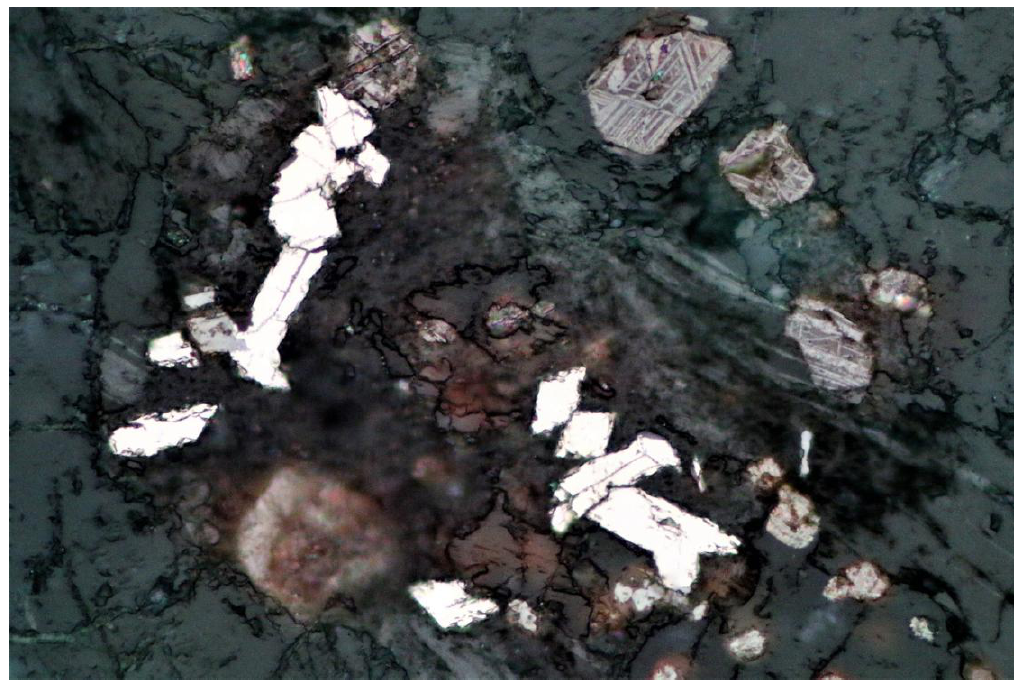
Figure 3. Single and twinned euhedral grains and radially grown crystal aggregates of ferroselite (bright cream) grown inside a host rock fragment (cf. Figure 1). Next to them (upper right) are titanomagnetite pseudomorphs (cf. Figure 2b). Polished section, plane polarized reflected light digital image, width 200 μm.